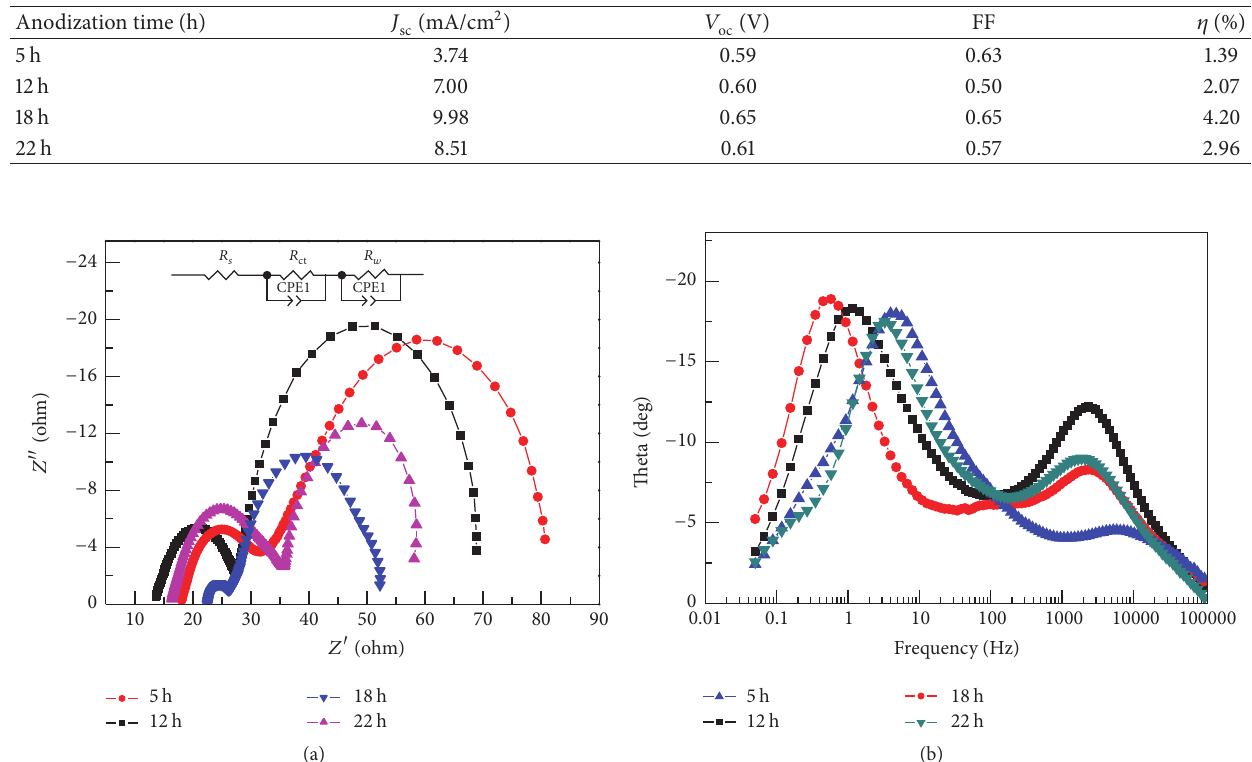
Table 1: Comparisons of the photovoltaic performances of DSSCs based on P25/TNT arrays double-layer films with different anodization time.